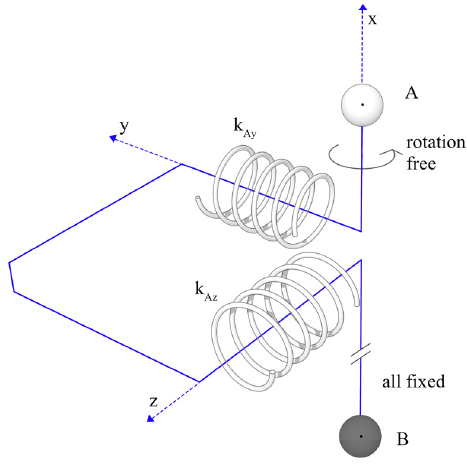
Figure 7. Connector concept by coupling used for modelling of the joints.